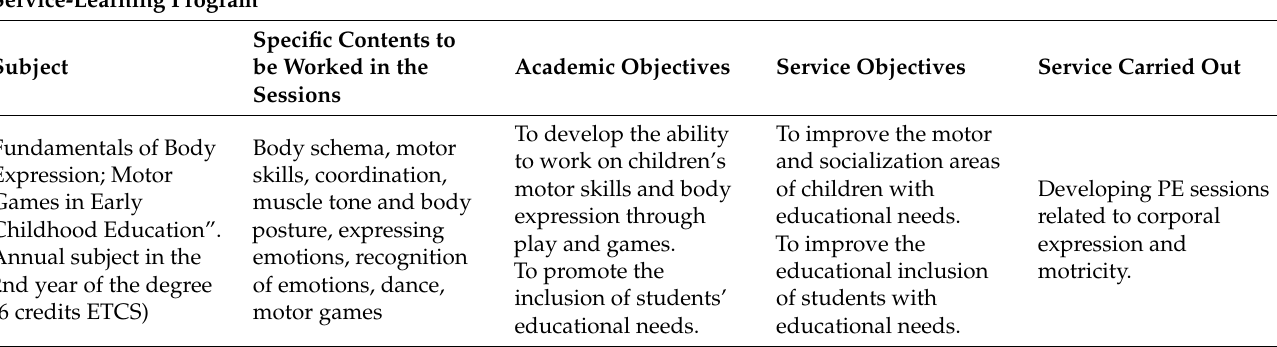
Table 1. Overview of the SL program.